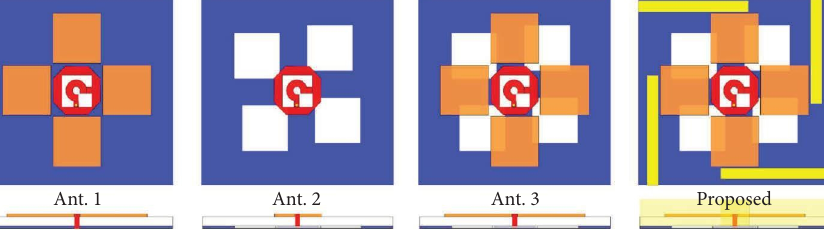
Figure 2: Four step-by-step designed models of the CP MPA.